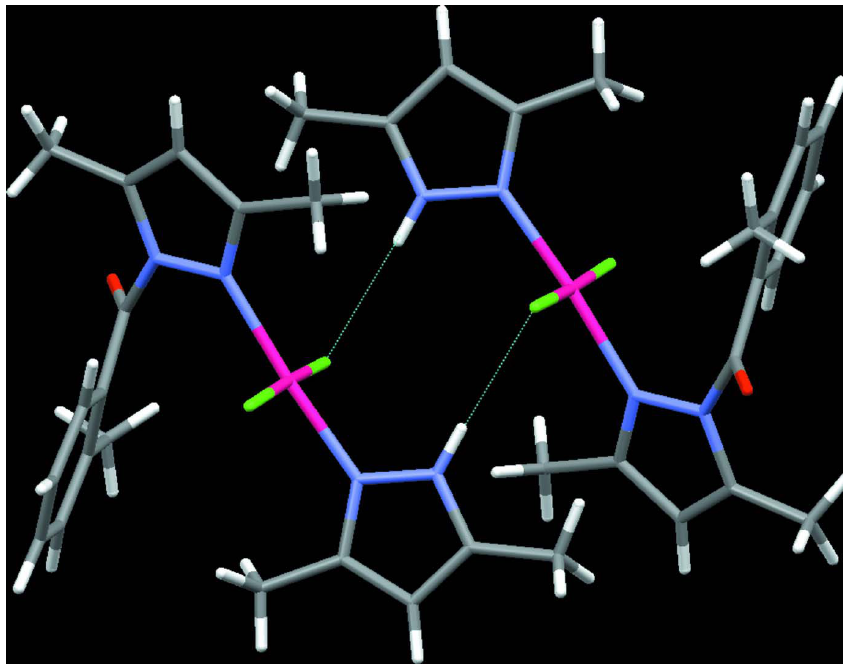
Figure 2 A hydrogen-bonded dimer in (I) with the H bonds indicated by thin blue lines. Dichlorido(3,5-dimethyl-1 H -pyrazole)[(3,5-dimethyl-1 H -pyrazol-1-yl)( o -